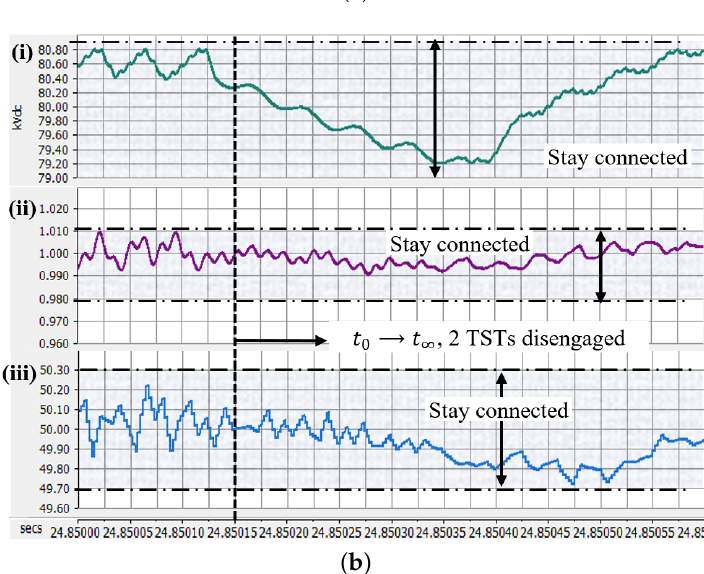
Figure 11. ( a ) measured RMS voltage and instantaneous voltage at DCCA AC-Link busbar upon disconnecting 2 TSTs in a cluster; ( b ) transient signals at bi-pole HVDC and PCC busbar upon disconnecting TSTs; (i) bi-pole ( + DC) voltage profile at sending-end region, ( kV DC ); (ii) voltage transient at PCC busbar, (p.u.); (iii) frequency transient at PCC busbar,